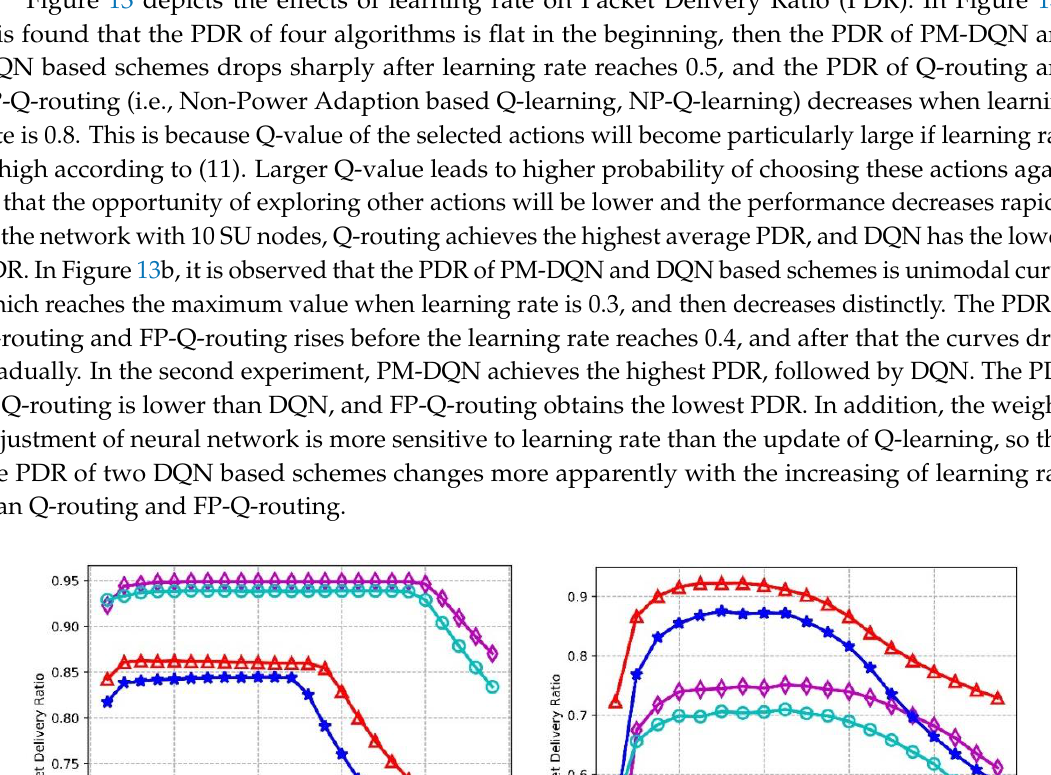
Figure 14. Average throughput vs. learning rate.